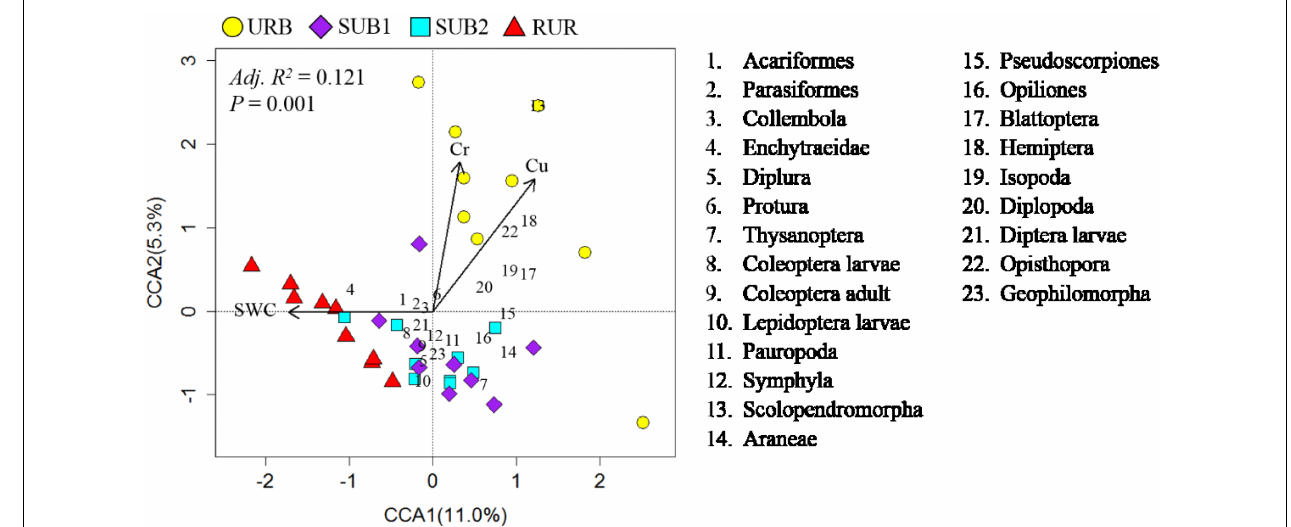
FIGURE 7 | Canonical correspondence analysis (CCA) ordination plot using soil physicochemical characteristic as the environmental data matrix and the abundance of soil fauna taxa as response variable. The CCA model is the best model selected by a backward stepwise procedure. Explained variance ( R 2 ) is the sum of all canonical eigen values and adjusted by Bonferroni method (Zuur et al., 2007). The P -values are based on a permutation test (999 permutations). The urbanization gradient sites are urban (URB), suburban 1 (SUB1), suburban 2 (SUB2), and rural (RUR)